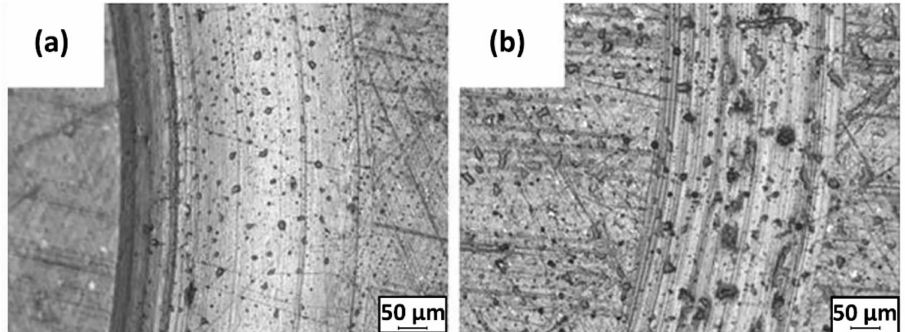
Figure 6. Optical photographs of worn surfaces of PI nanocomposites with 0.5 wt.% GO under ( a ) dry sliding and ( b ) seawater lubrication (Reproduced with permission from C. Min, C. Shen, M. Zeng, P. Nie, H. J. Song, S. Li, Monatshefte für Chemie—Chemical Monthly; published by Springer, 2017)